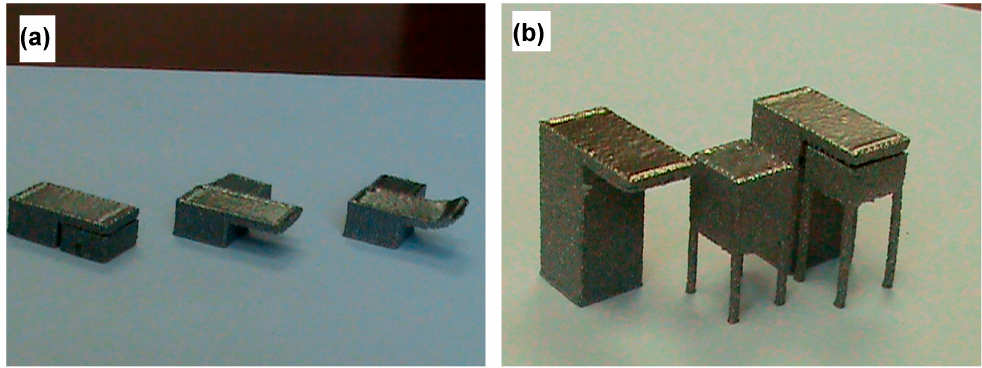
Figure 10. ( a ) Fabricated overhang parts using heat supports with different gap distances, from Left to Right: 7, 9, and 11 layers. ( b ) Overhangs with heat support of different thicknesses: 10 mm (left) and 5 mm (right).